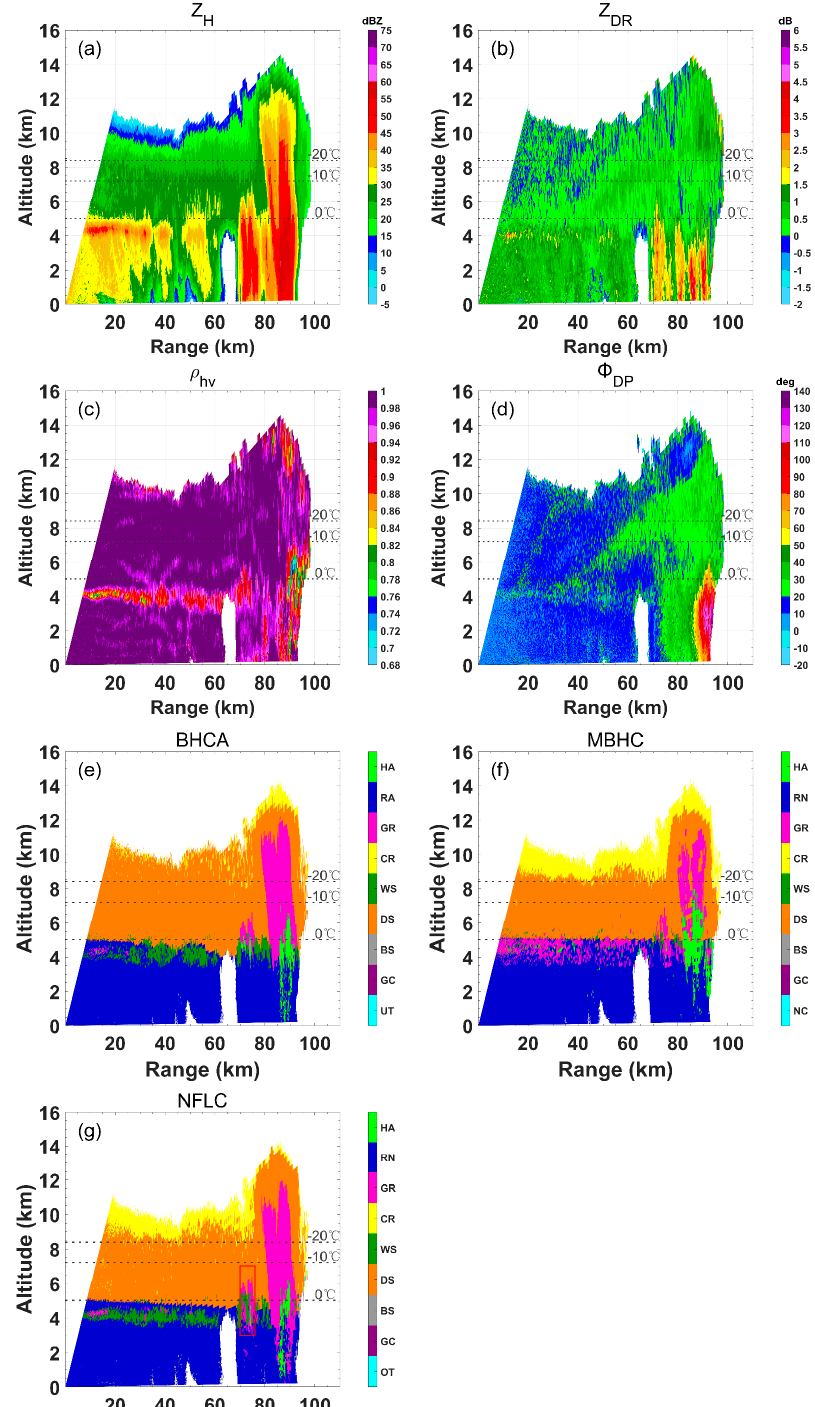
Figure 4. Range-height indicator (RHI) of ( a ) Z H , ( b ) Z DR , ( c ) ρ hv , ( d ) Φ DP , and corresponding hydrometeor classification results by the ( e ) Bayesian hydrometeor classification algorithm (BHCA), ( f ) Marzano-Bayesian hydrometeor classification algorithm (MBHC) and ( g ) NCAR fuzzy logic classifier (NFLC) at 89. 93 ° azimuth along black dash line in Figure 3, at 23:11 LST on 30 July 2014. The black dashed lines represent the temperature level of 0 ℃ , − 10 ℃ and − 20 ℃ from bottom to top, respectively. The red rectangle highlights the different classification results.